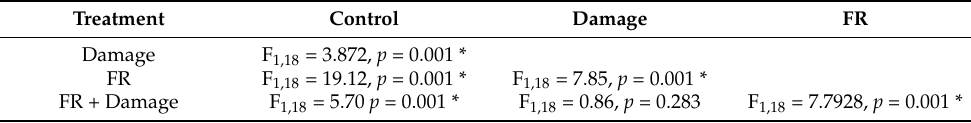
Table 1. VOC composition as a function of light quality and herbivore damage. Pairwise (post hoc) comparison of the VOC bouquets emitted from Solidago altissima plants that had been exposed to control light (Control) or regular light supplemented with FR light (FR), while being not damaged or damaged by two larvae of S. frugiperda in L3 instar (Damage).